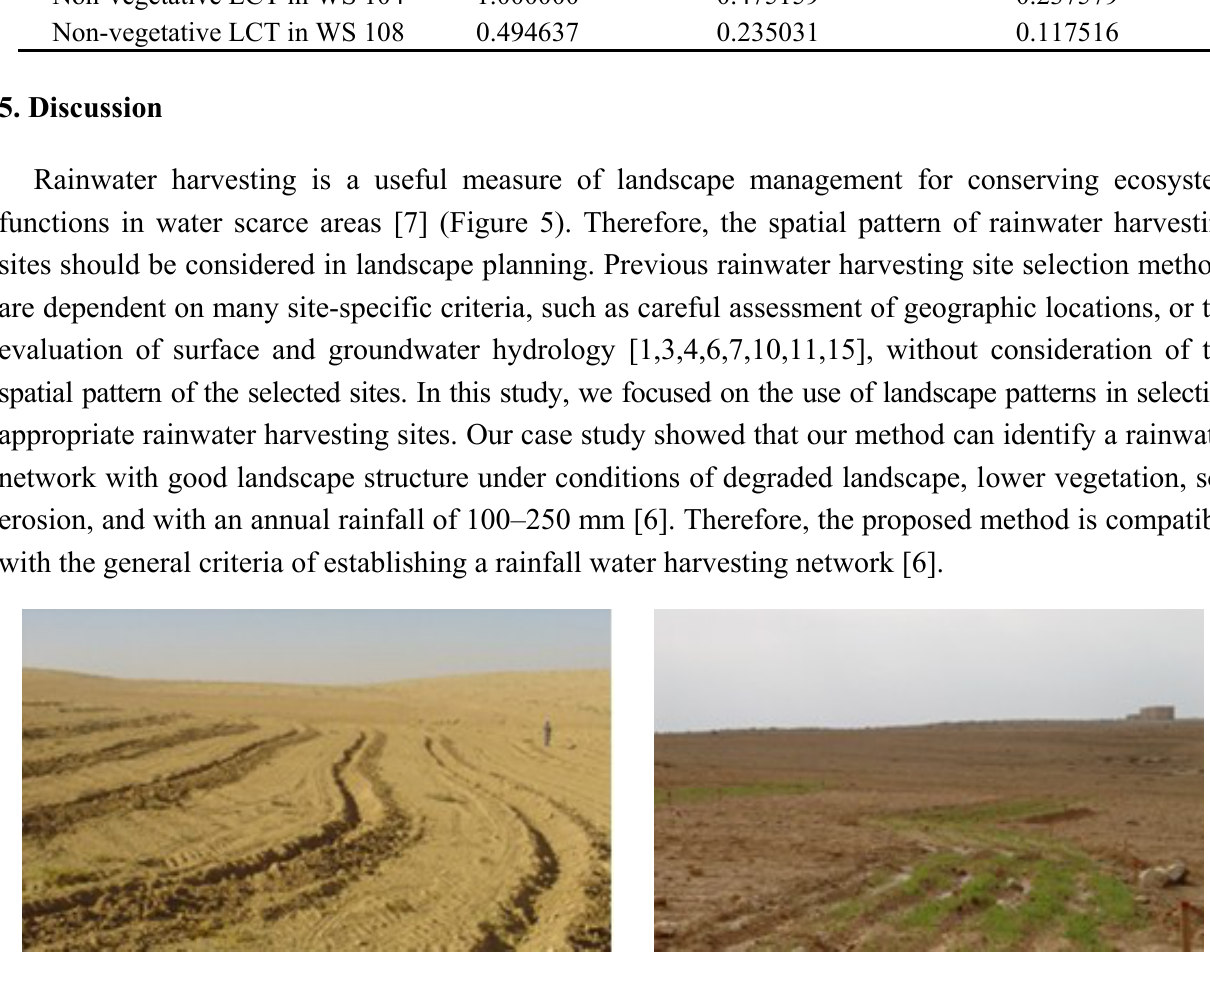
Figure 5. Before/after rainwater harvesting in a non-vegetative LCT. ( A ) Establishing rainwater harvesting in a barren non-vegetative LCT; ( B ) The growth of vegetation cover after implementing rainwater harvesting in a non-vegetative LCT. Source: The Jordanian National Centre for Agricultural Research and